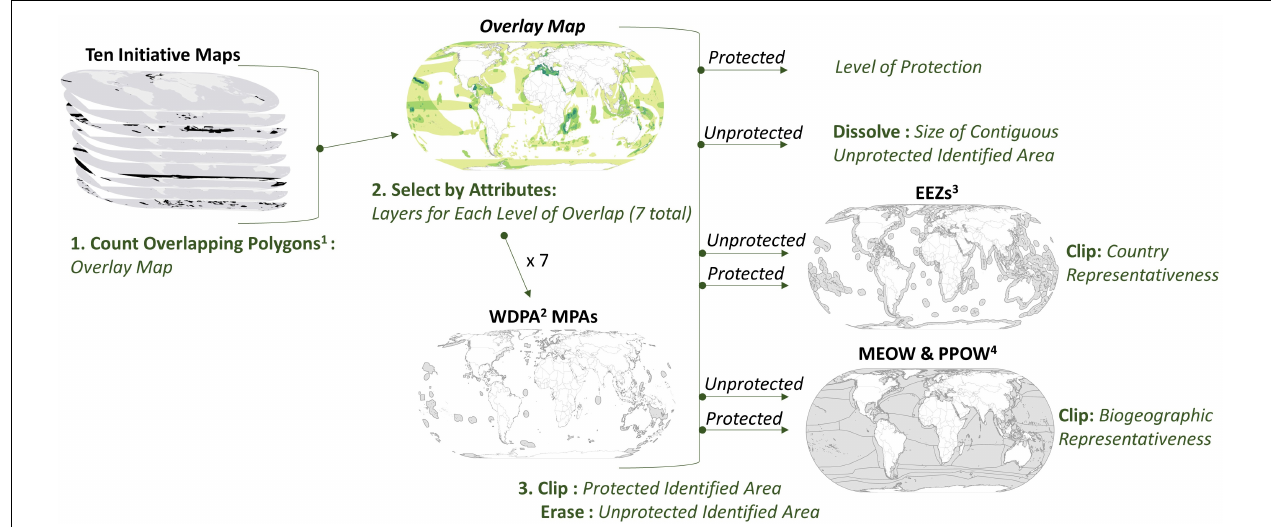
FIGURE 1 | Conceptual diagram showing spatial analysis workflow. Names of data layers resulting from our analysis are italicized. (1) Count Overlapping Polygons Tool (Honeycutt, 2012), (2) World Database on Protected Areas (UNEP-WCMC and IUCN, 2019a), (3) Exclusive Economic Zones (Flanders Marine Institute, 2018), (4) Marine Ecoregions of the World (Spalding et al., 2007) and Pelagic Provinces of the World (Spalding et al.,